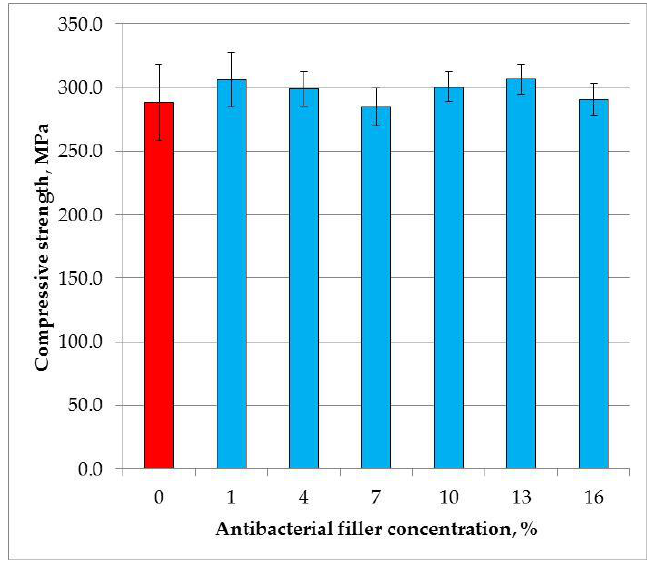
Figure 3. Mean values and standard deviations of compressive strength.